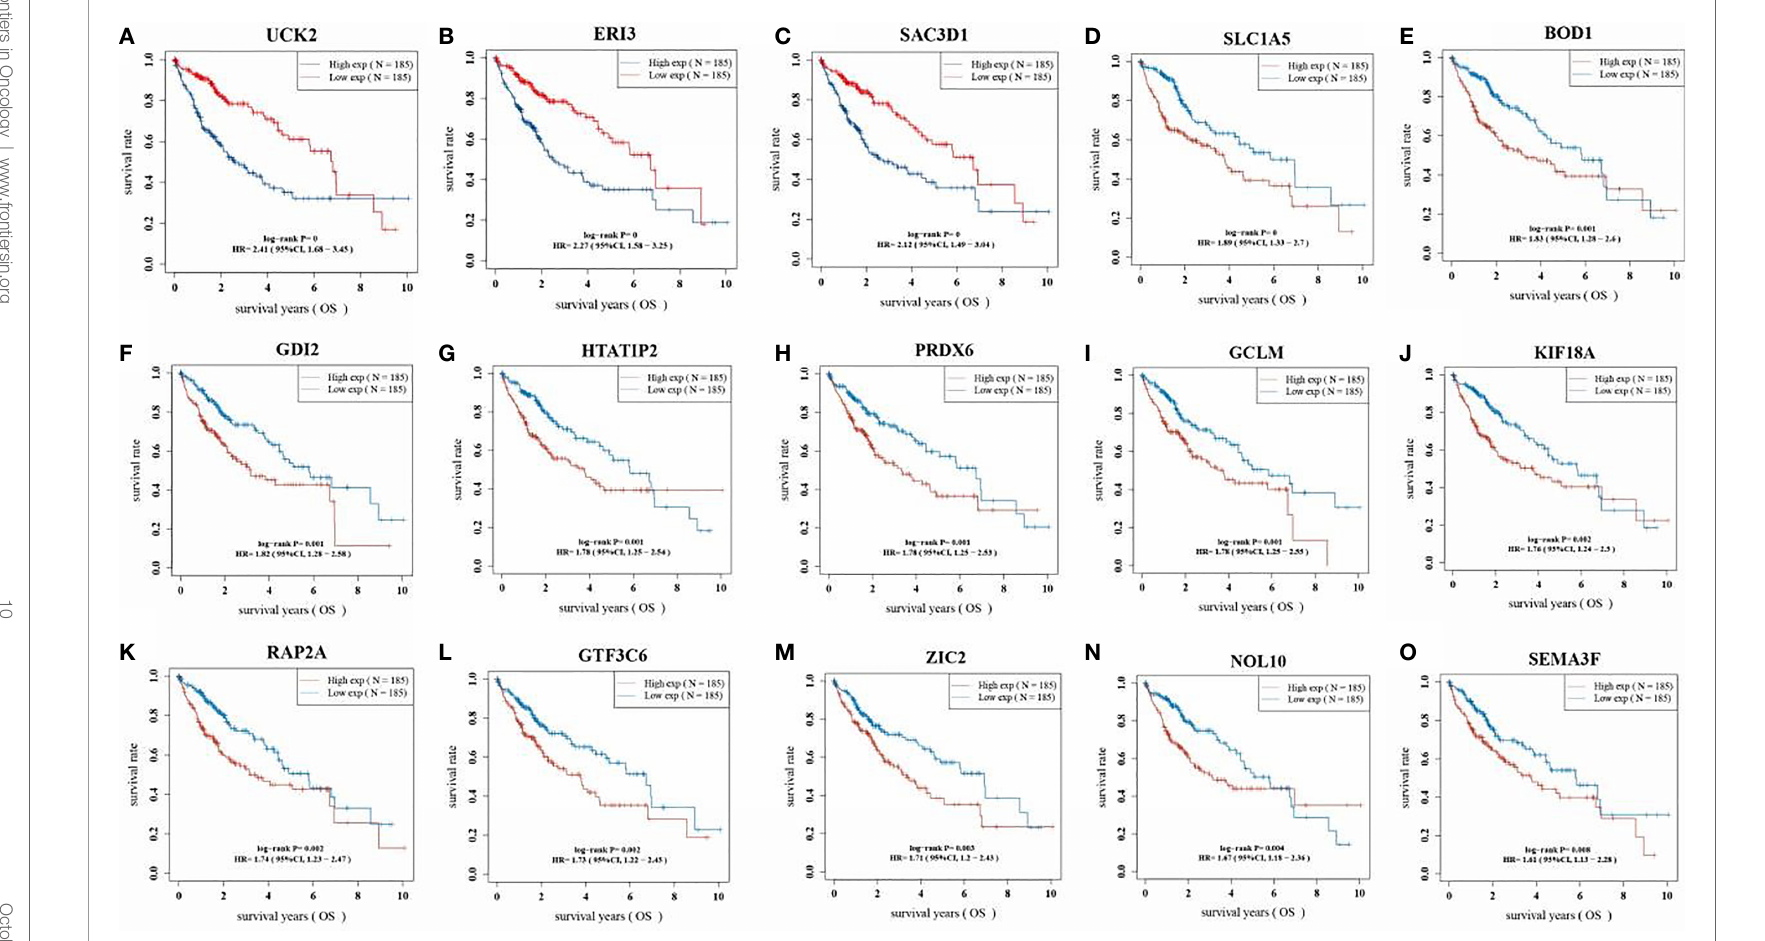
FIGURE 6 | Kaplan Meier curve of 15 gene signatures in LIHC patients. ( A : UCK2 ; B : ERI3 ; C : SAC3D1 ; D : SLC1A5 ; E : BOD1 ; F : GDI2 ; G : HTATIP2 ; H : PRDX6 ; I : GCLM ; J : KIF18A ; K : RAP2A ; L : GTF3C6 ; M : ZIC2 ; N : NOL10 ; O : SEMA3F